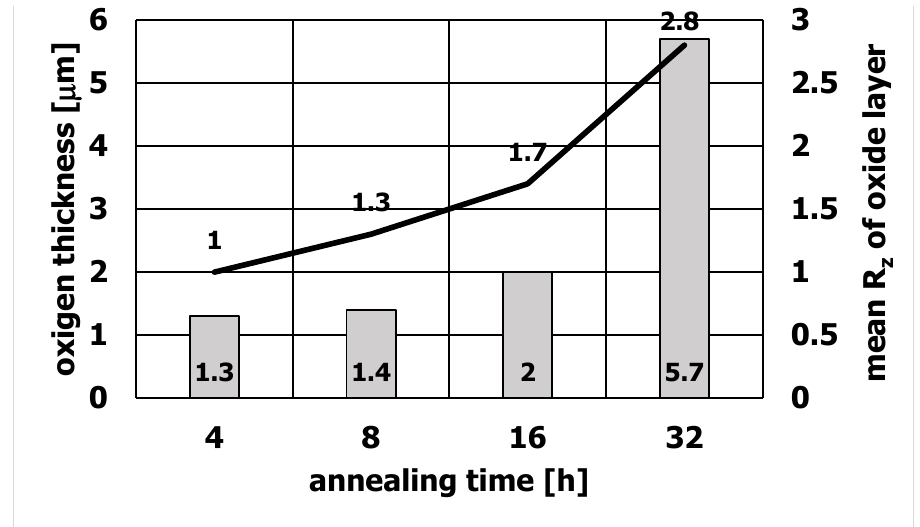
Figure 12. Thickness and roughness of the oxide deposited on the WNLV steel matrix.